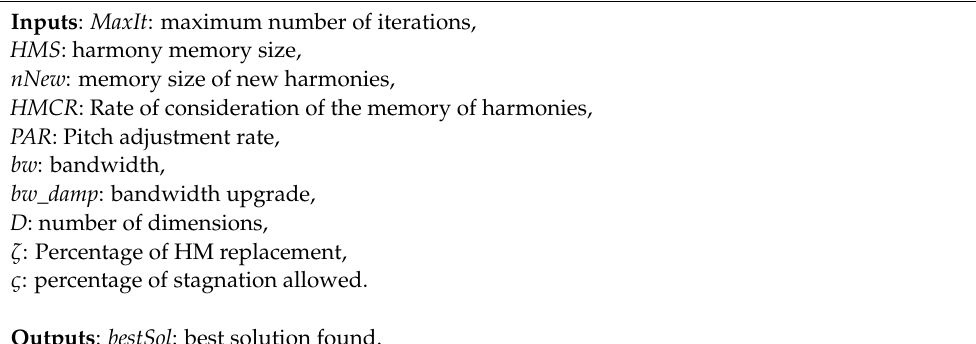
Algorithm 5 . Hybrid Harmony